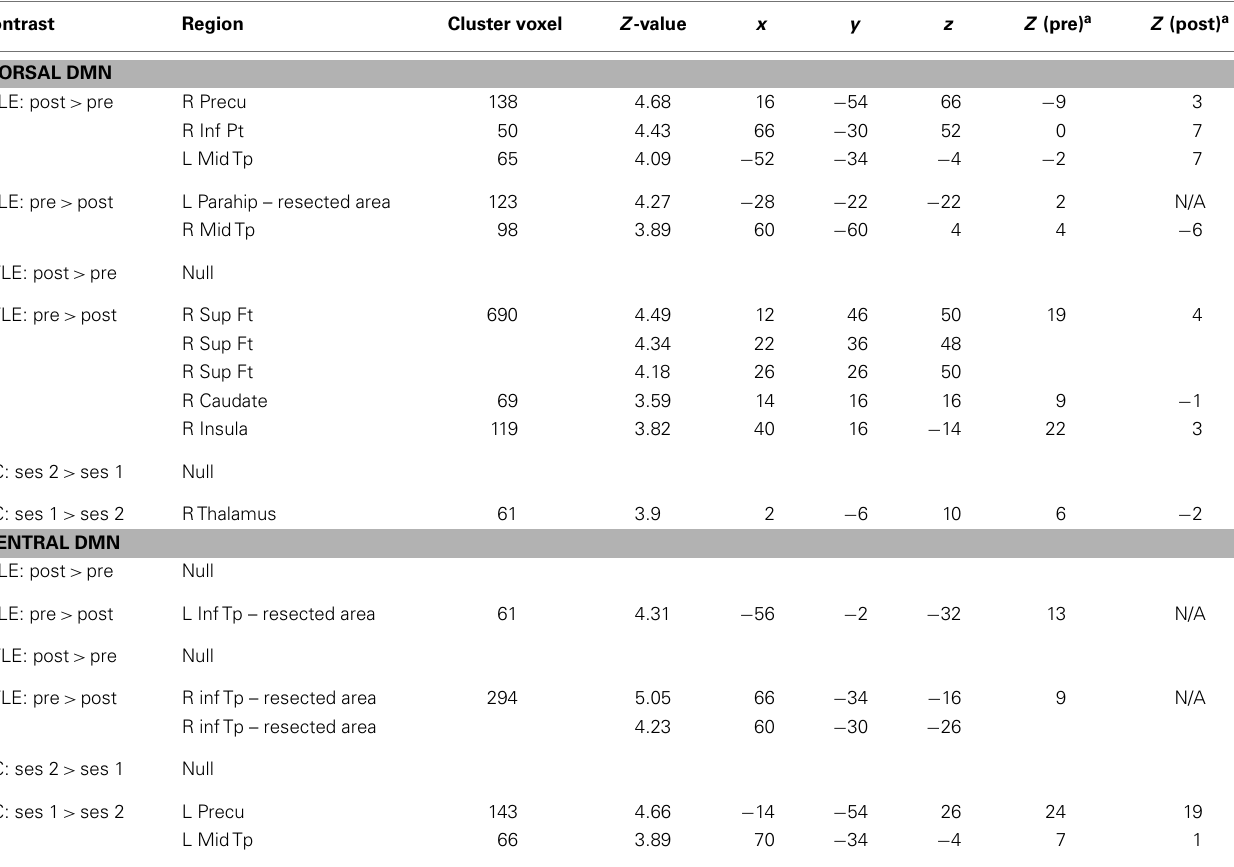
Table 3 | Description of the changes between the two sessions, within each experimental group, for each DMN subdivision .